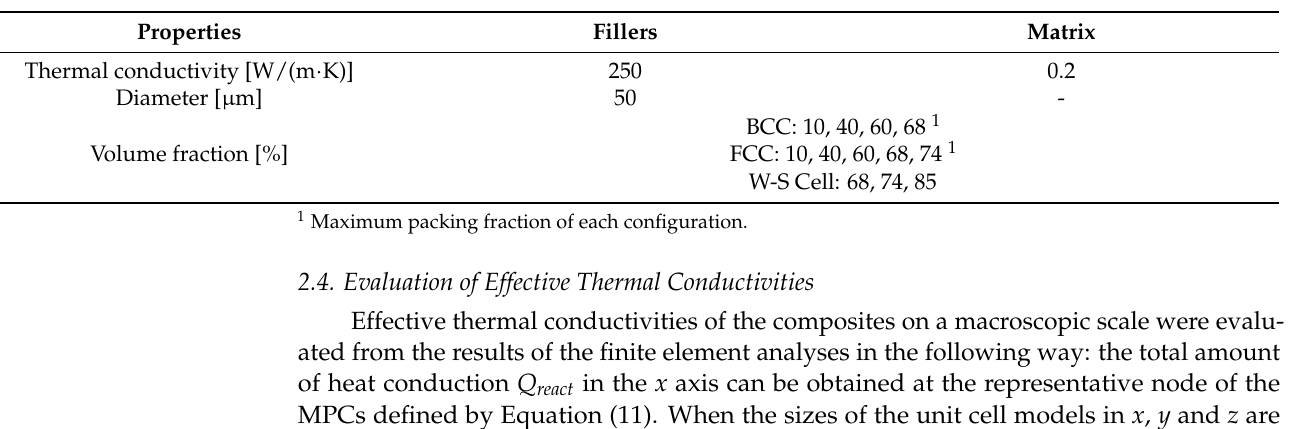
Table 1. Material properties used for